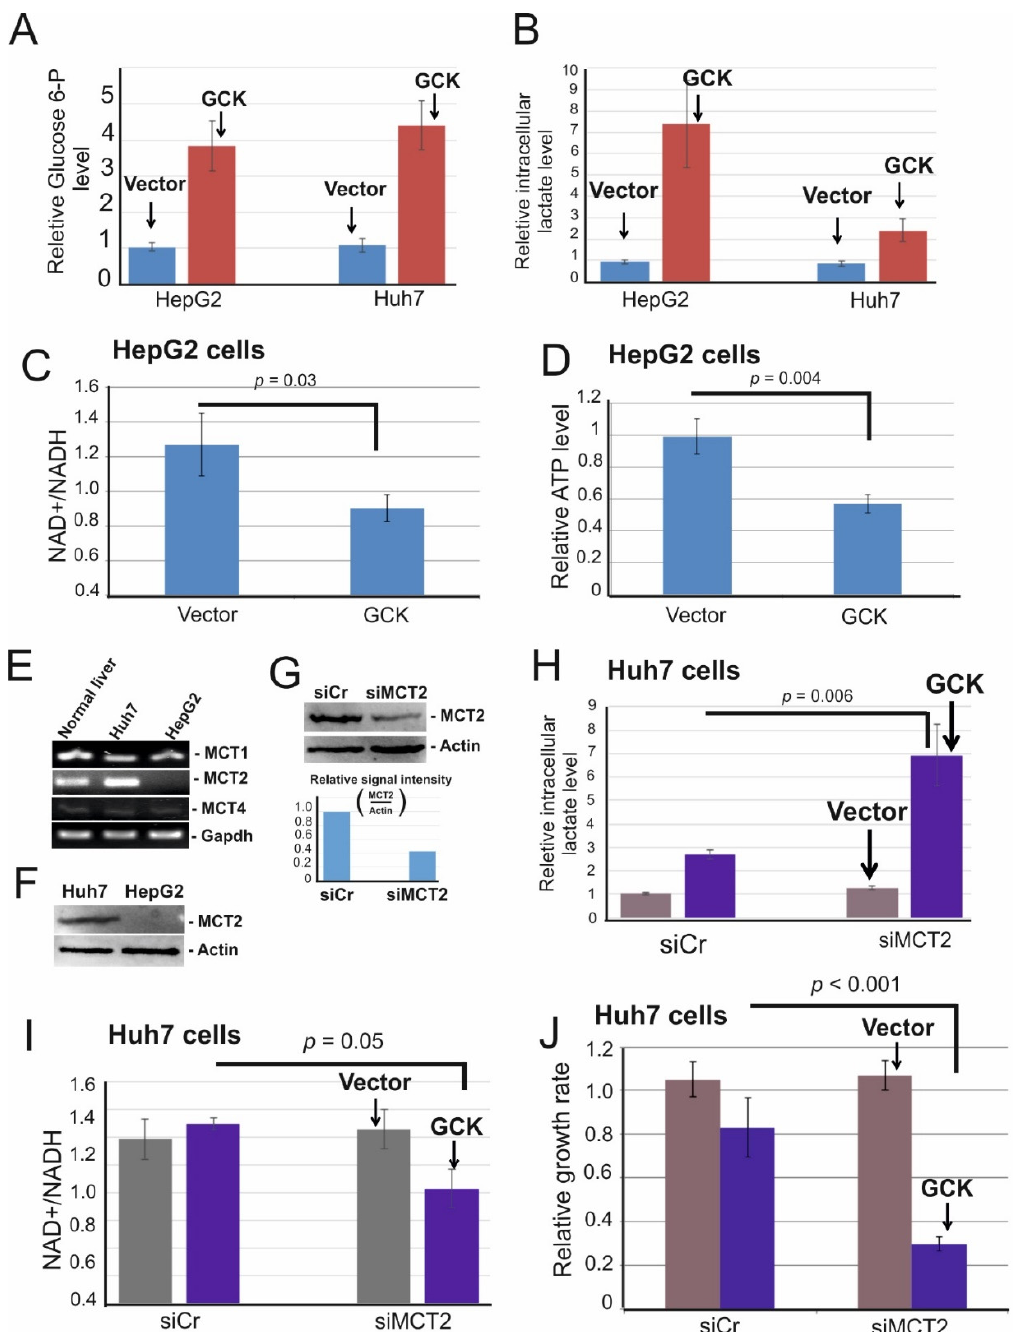
Figure 4. GCK overexpression caused intracellular lactate accumulation and induced energy crisis due to NAD+ depletion. ( A,B ) Huh7 and HepG2 cells were transfected with a control vector (Vector) and FLAG-tagged GCK. Two days after transfection cells were homogenized and deproteinized. Deproteinized lysates were then supplied for glucose-6-phosphate assay ( A ) or lactate assay ( B ). ( C,D ) HepG2 cells were transfected with a control vector (Vector) and FLAG-tagged GCK. Huh7 and HepG2 cells were used to examine the expression of MCT1-4. GAPDH was used as the loading control. ( F ) Cell lysates of Huh7 and HepG2 cells were applied for MCT2 specific immunoblot. Actin was used as the loading control. ( G ) Huh7 cells were transfected with siRNA control (siCr) and siMCT2. Three days after transfection cells were lysed and subjected to MCT2 and actin-specific immunoblotting. Immunoblot signal was quantified using ImageQuant. ( H,I ) Huh7 cells were transfected with control siRNA (siCr) and siMCT2. After 24 hours, cells were transfected with vector control and FLAG–GCK and further cultured for two days. Cells were then supplied for lactate- ( H ) and NAD+/NADH assay ( I ) as described above. ( J ) Sister cultures of (J) were subjected to crystal violet assay. Numbers are mean ± SD. p : p - value.